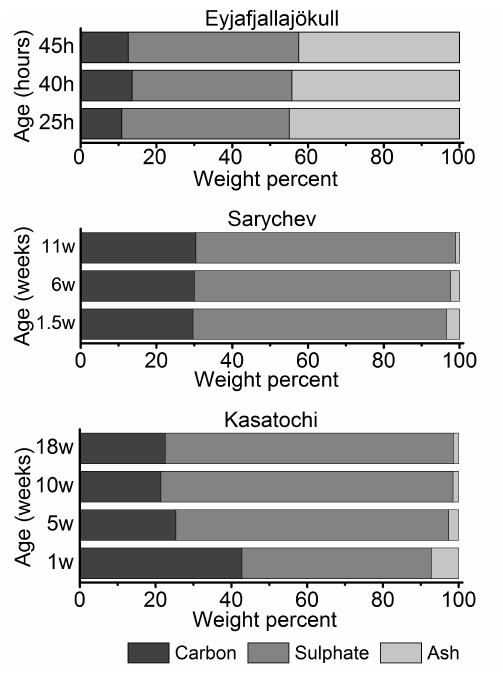
Fig. 5. Major components of aerosol samples collected following eruptions in Eyjafjallaj¨okull, Sarychev and Kasatochi. Aerosol col- lected 1.5, 6 and 11 weeks after the eruption in Sarychev are shown as averages of 3, 6 and 2 samples respectivley. The composition of aerosol collected 18 weeks after the Kasatochi eruption are an av- erage of 3 samples. The remaining aerosol compositions are each represented by only one sample. The carbonaceous fraction is av- eraged over all samples of the aerosol from Sarychev, see text for further